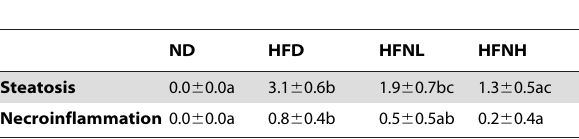
Table 2. Effects of nuciferine on scores for hepatic steatosis and